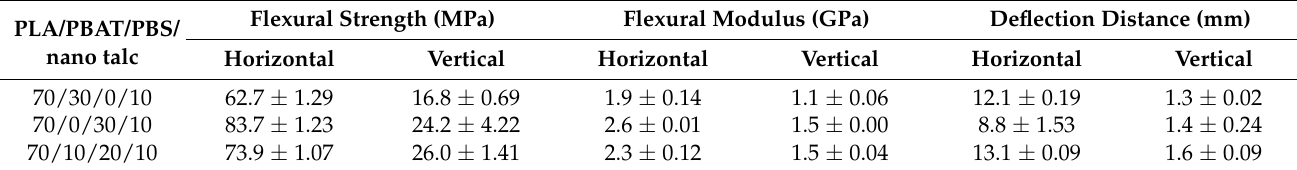
Table 6. Flexural properties of PLA/PBAT/PBS/nano talc composite 3D